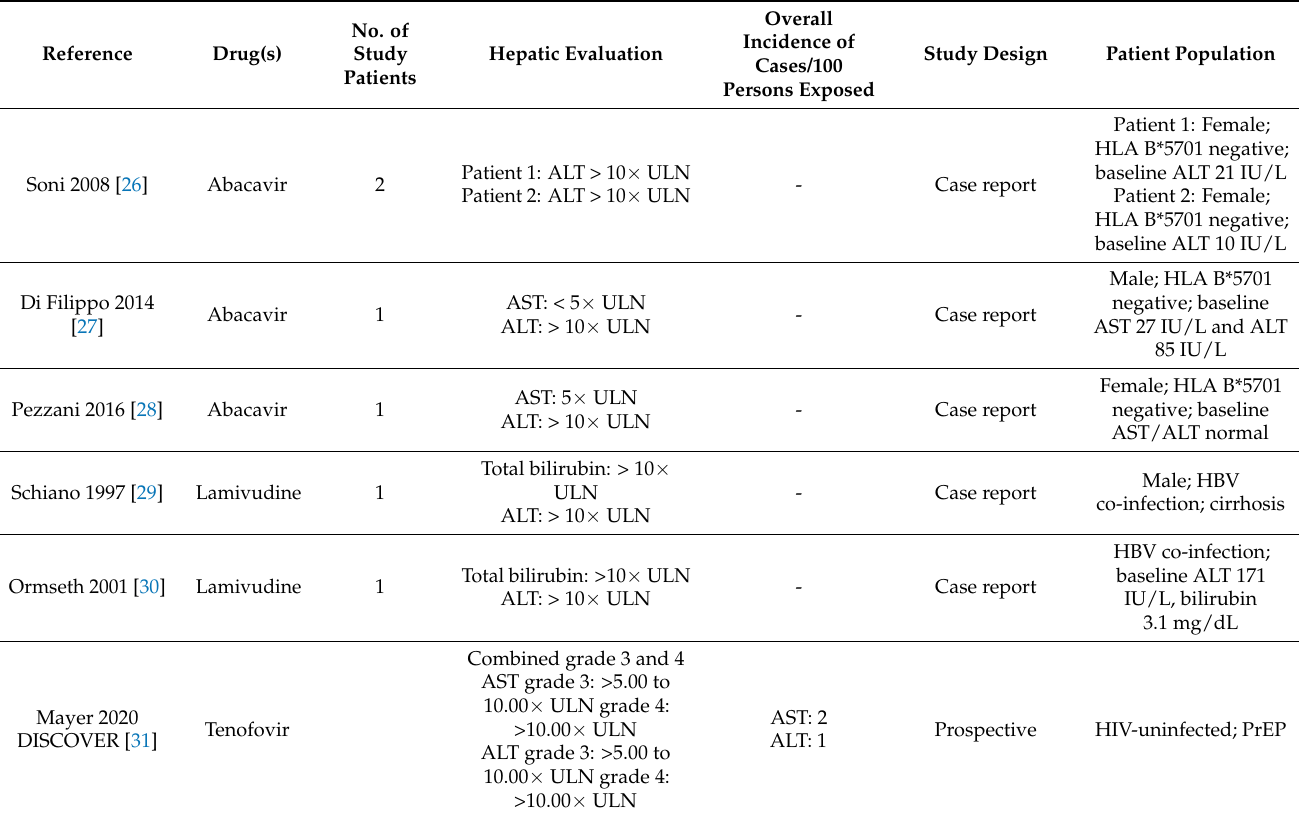
Table 3. Clinical trial evaluation of hepatic toxicity and incidence for nucleoside reverse transcriptase inhibitors.